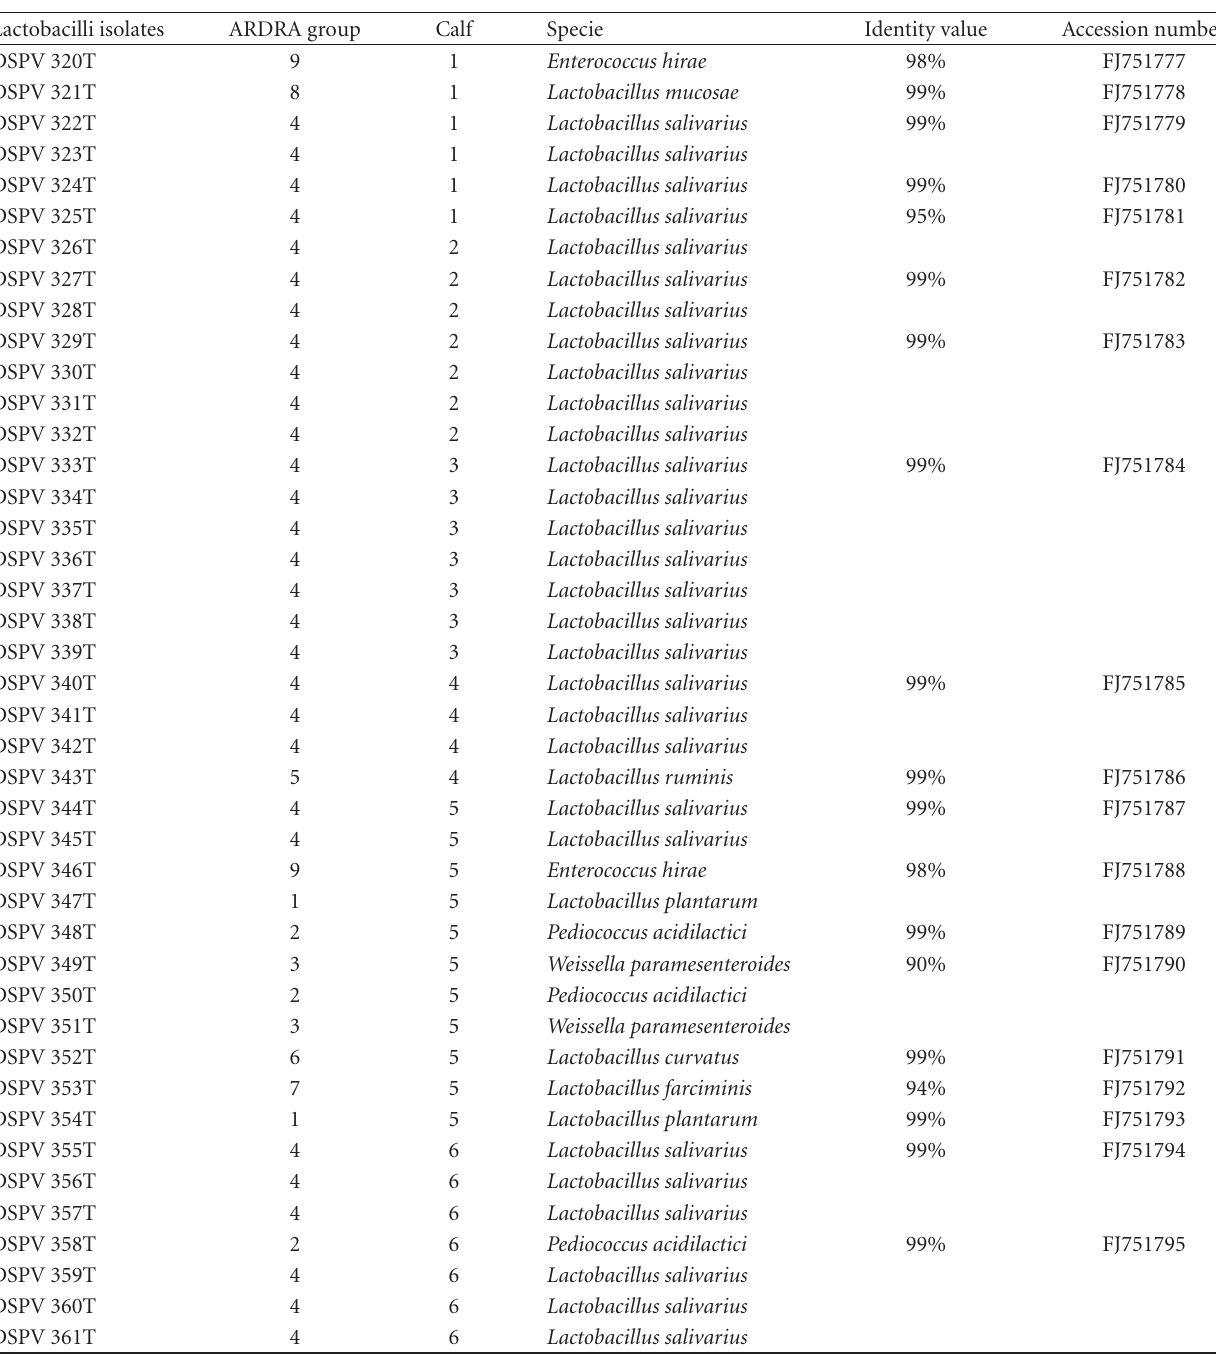
Table 1: List of bacterial isolated in this study and their closest a ffi liation according to the 16S rDNA sequencing (1500 pb) or by belonging to the same ARDRA